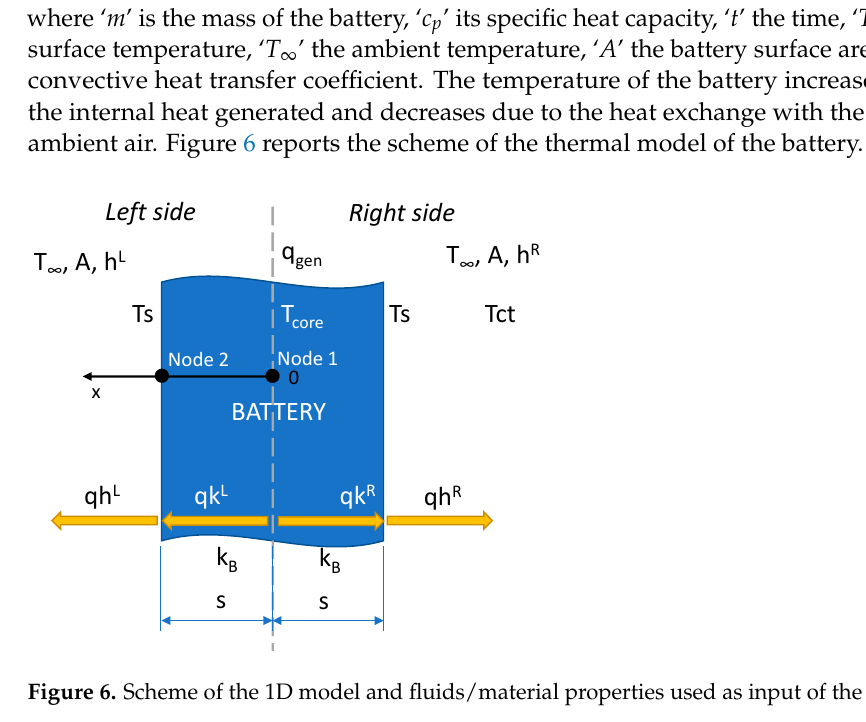
Figure 6. Scheme of the 1D model and fluids/material properties used as input of the battery